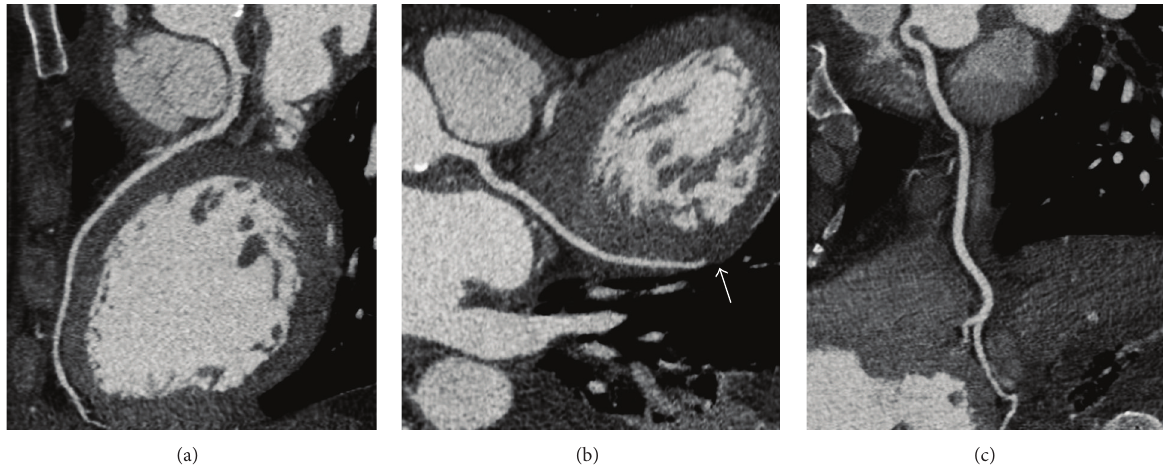
Figure 5: Curved multiplanar reformatted images of the left main and left anterior descending (a), left circumflex and terminal obtuse marginal branch (b), and right coronary arteries (c). There is an abrupt occlusion of the mid obtuse marginal branch (arrow) without significant coronary artery disease, suggesting that the coronary obstruction was likely embolic in